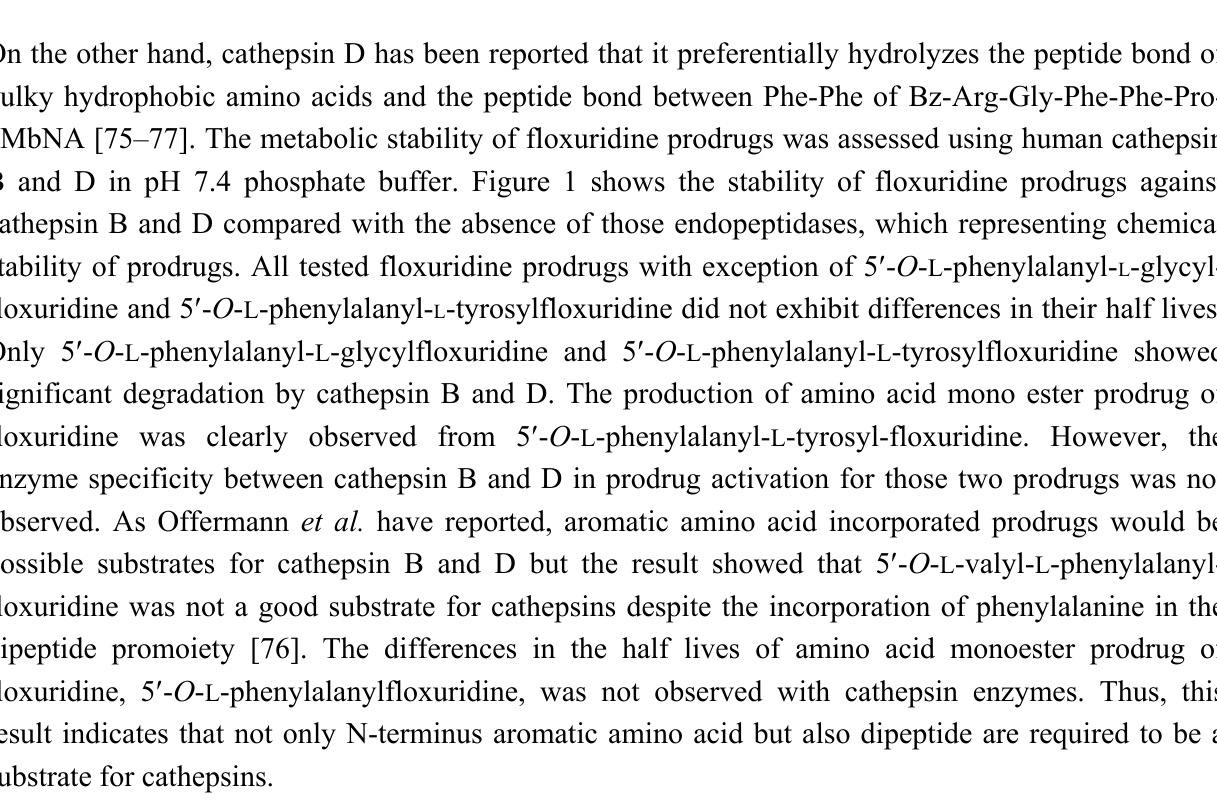
Table 2. Prodrug stability in capan-2 cell homogenate with the presence and the absence of inhibitors.